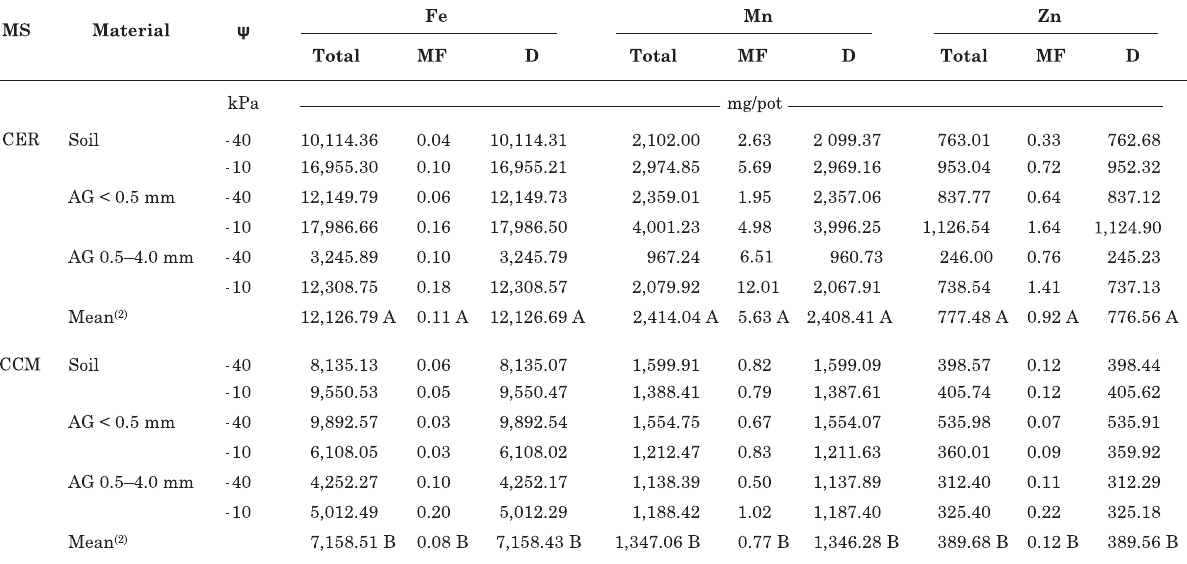
Table 4. Total Fe, Mn and Zn accumulation in maize plants and quantities supplied by mass flow (MF) and diffusion (D), considering the material used for testing, soil or aggregates (AG), the water potential (ø) and the management system (MS)